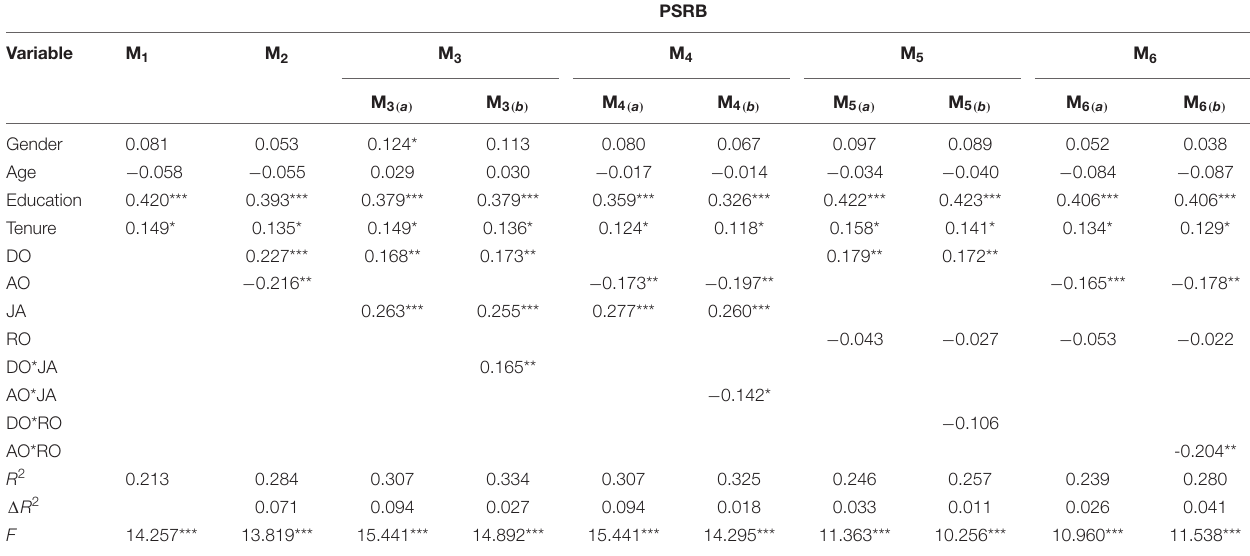
TABLE 3 | Results of hierarchical regression modeling equation predicting PSRB.